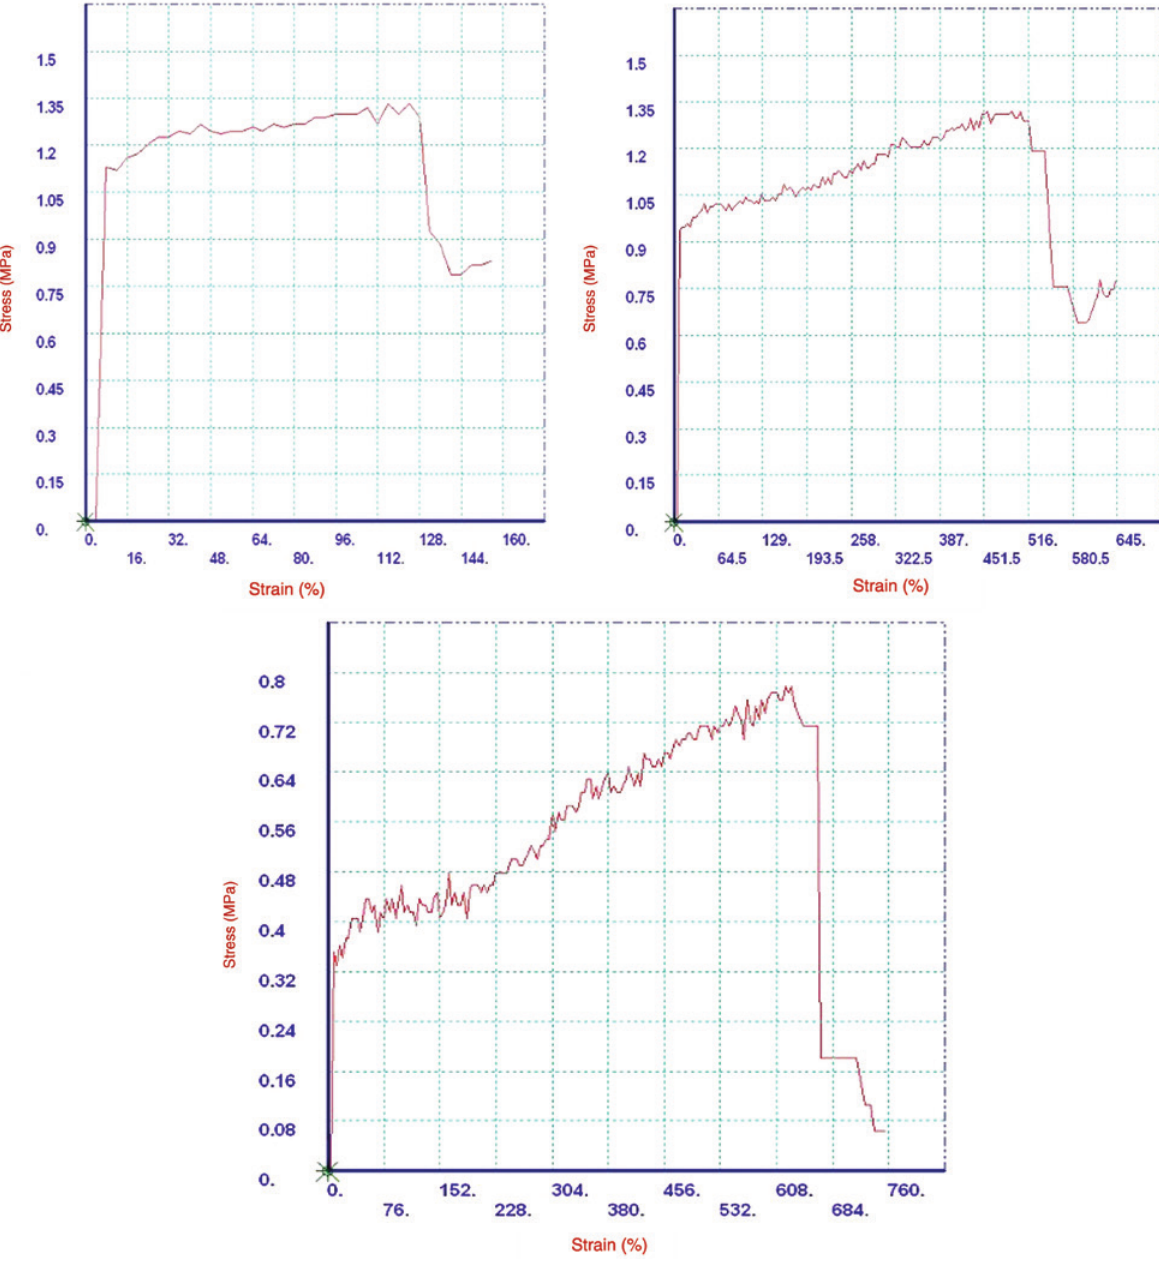
Figure 5: Initial properties of coir fiber-reinforced vulcanized NR composite.